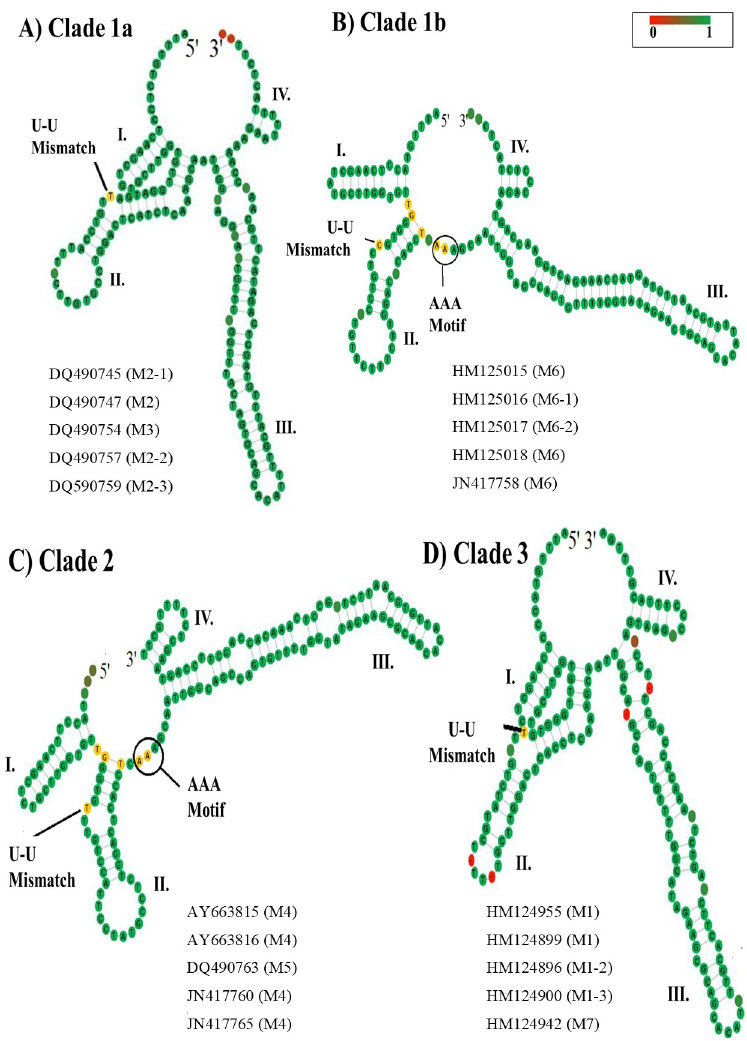
Fig 10. Phylogram based on 26 Ampelomyces ITS2 S2s shows that the S2s are not associated with PM hosts. The phylogram with the highest log likelihood (-829.62) is shown based on the Kimura two-parameter DNA model and an evolutionary rate among sites modelled with a discrete gamma distribution (+G) parameter = 0.90. The ML bootstrap values > 60% are indicated over the branches and are expressed as percentages. The scale bar represents the nucleotide substitutions per site. The tree was edited with FigTree v1.4.4 software. The GenBank accession numbers are indicated before the taxa names. Abbreviations: ITS2 S2 variations of main Models 1 (M1, and M1-3); Models 2 (M2, M2-1 and M2-3); Model 3 (M3); Model 4 (M4); Model 5 (M5); Models 6 (M6-1 and M6-2); and Model 7 (M7). only present in Ampelomyces extracted from E . necator in clade 1b ( Fig 11B ) and in Ampelo- myces extracted from P . leucotricha and P . ferruginea in clade 2 ( Fig 11C ).